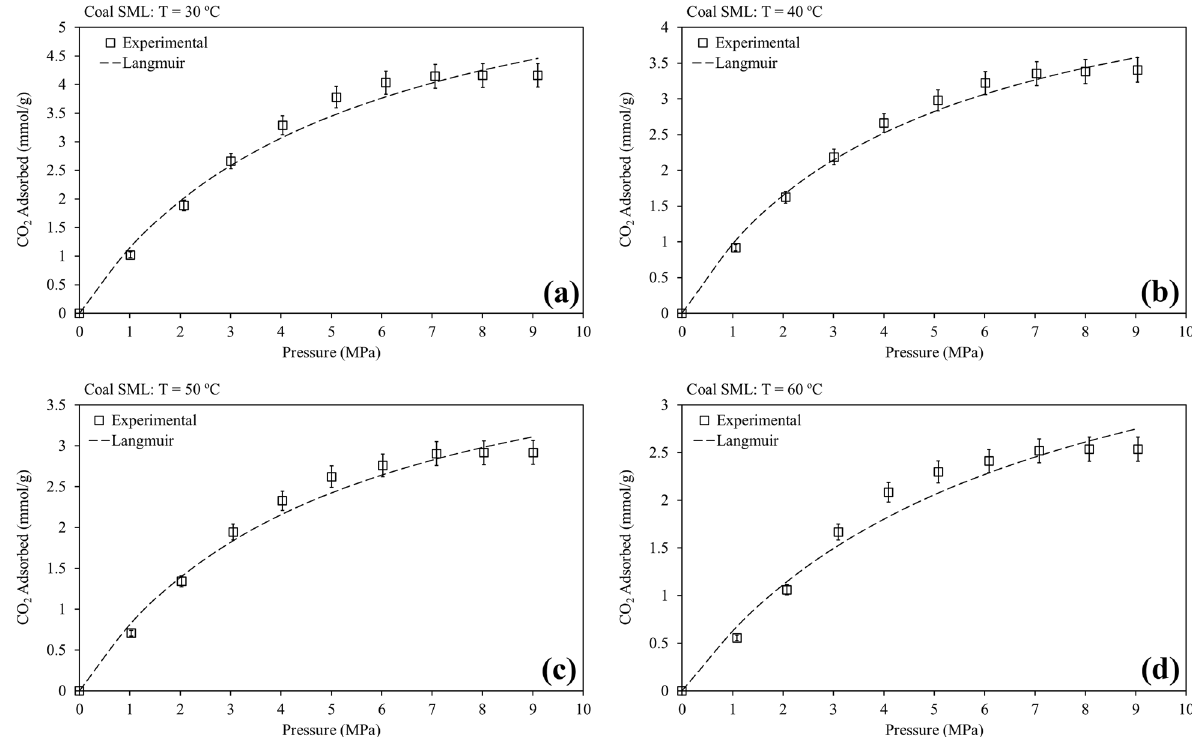
Fig. 2 Langmuir isotherm model fit for pure CO 2 sorption on Coal SML at a 30 ºC, b 40 ºC, c 50 ºC, and d 60 ºC